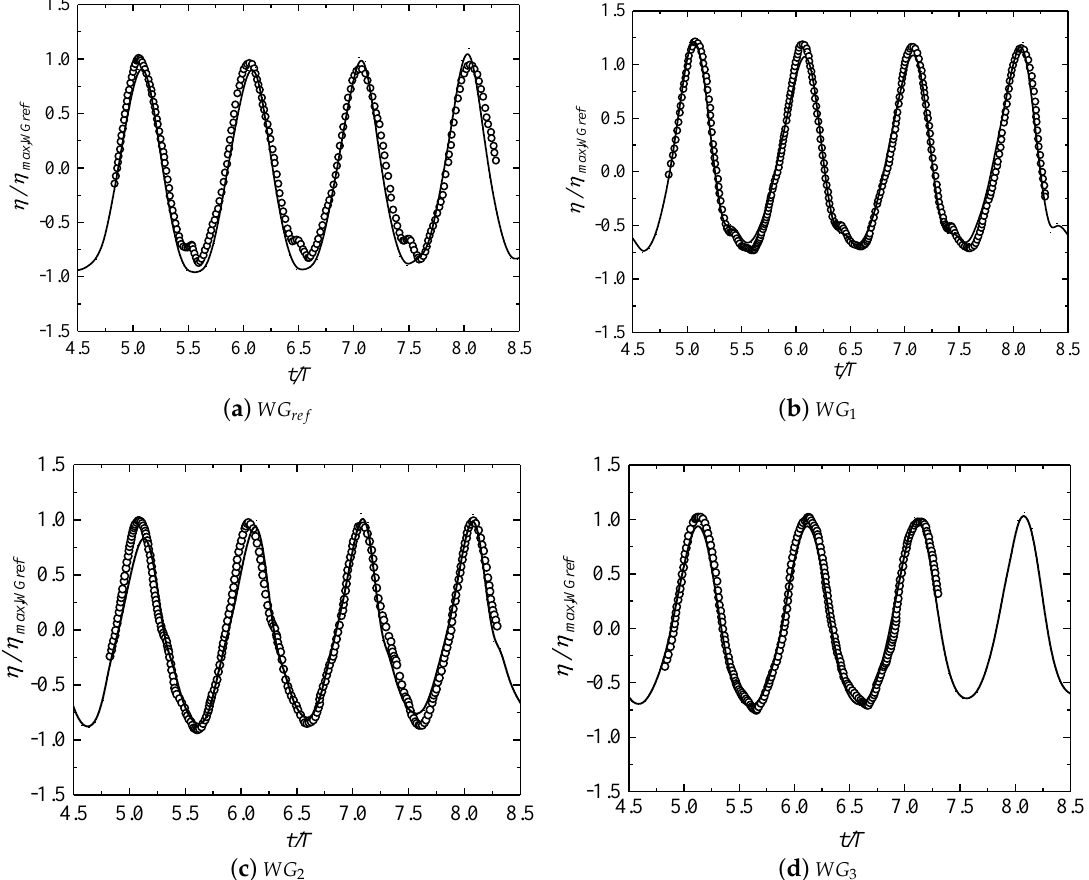
Figure 5. Time histories of the dimensionless free surface displacement at four locations. Circles: the experimental data; Solid lines: numerical results.